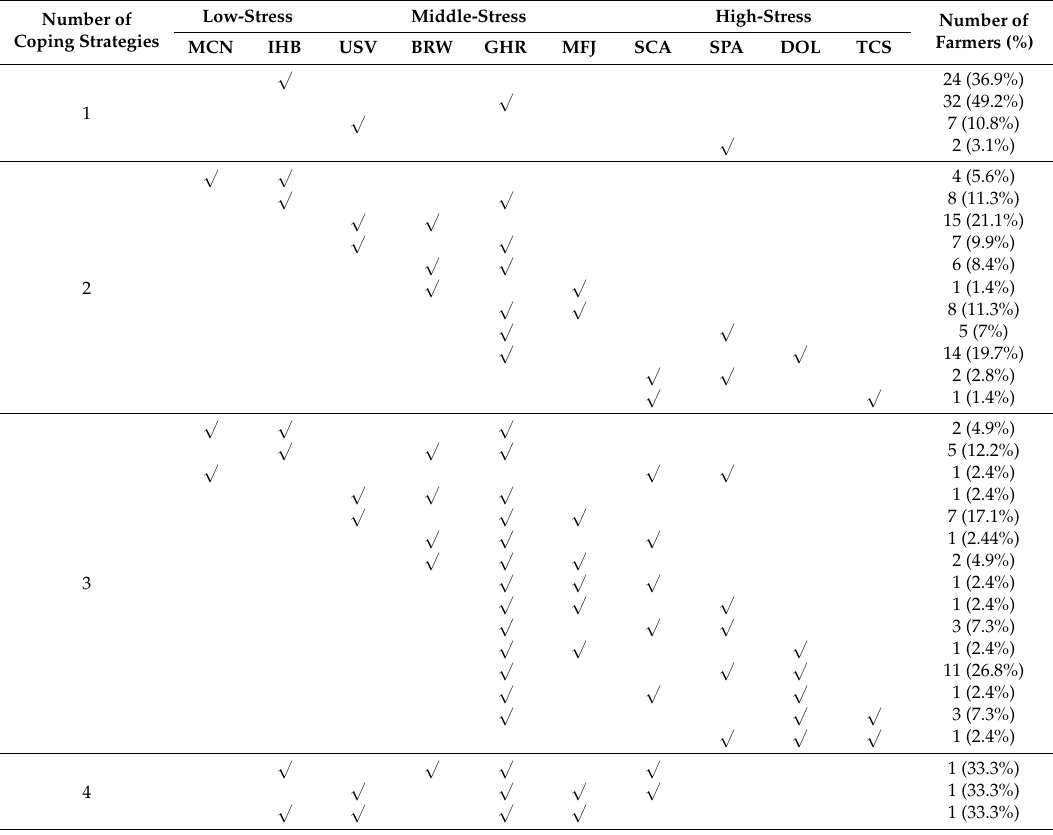
Table 7. Combination of ex post coping strategies adopted by